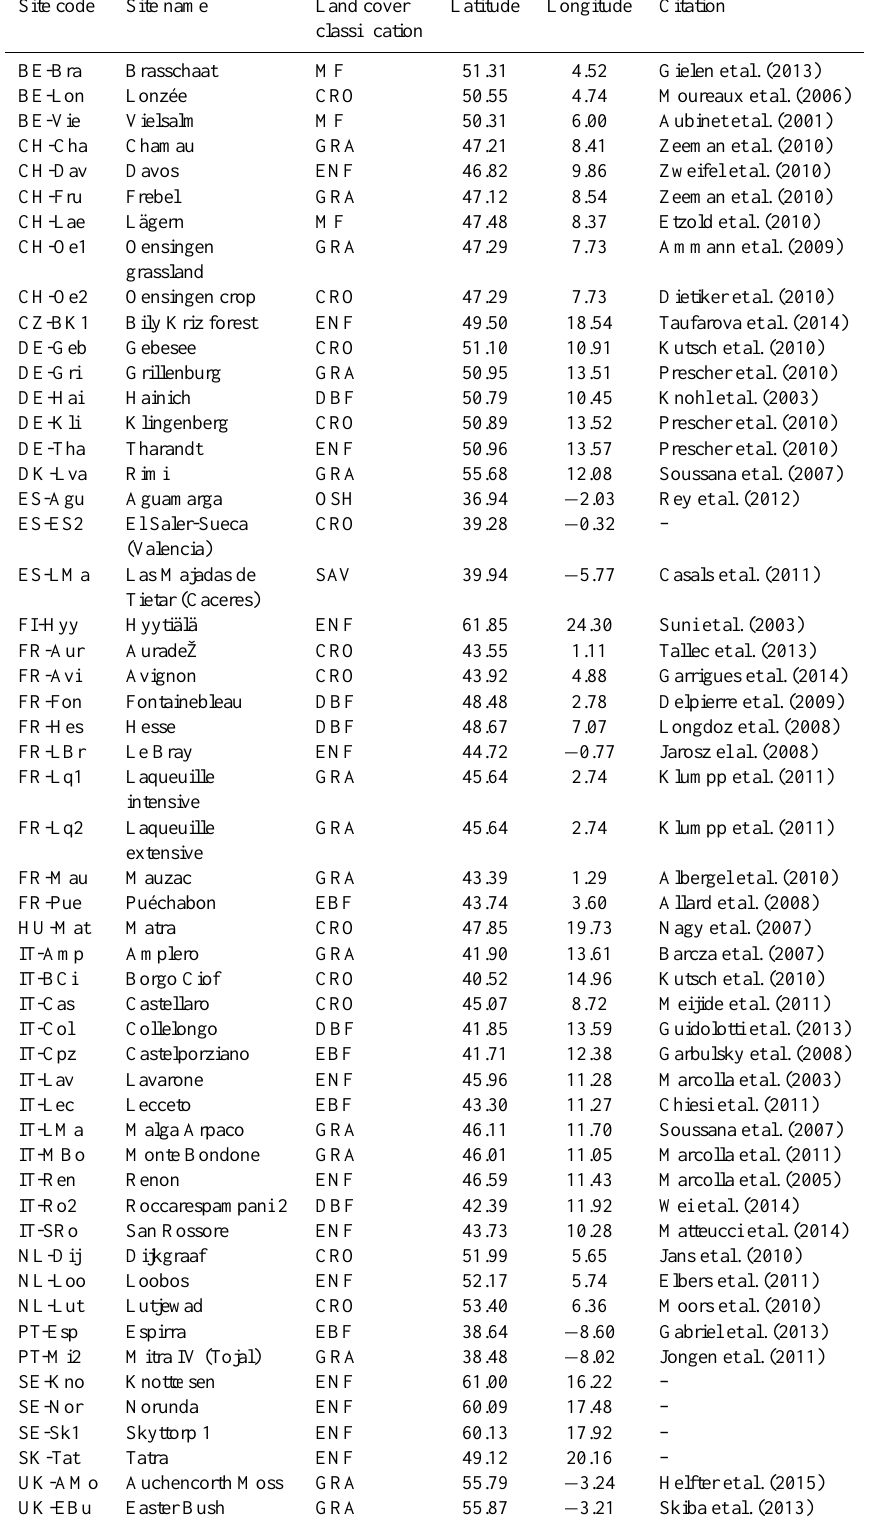
Table 1. Eddy covariance sites measuring CO 2 fluxes that were used in the analysis. The land cover classification used is coded as fol- lows: CRO, DCF, EVG, MF, GRA, OSH, and SAV for crops, deciduous forest, evergreen forest, mixed forest, grass, shrub, and savanna